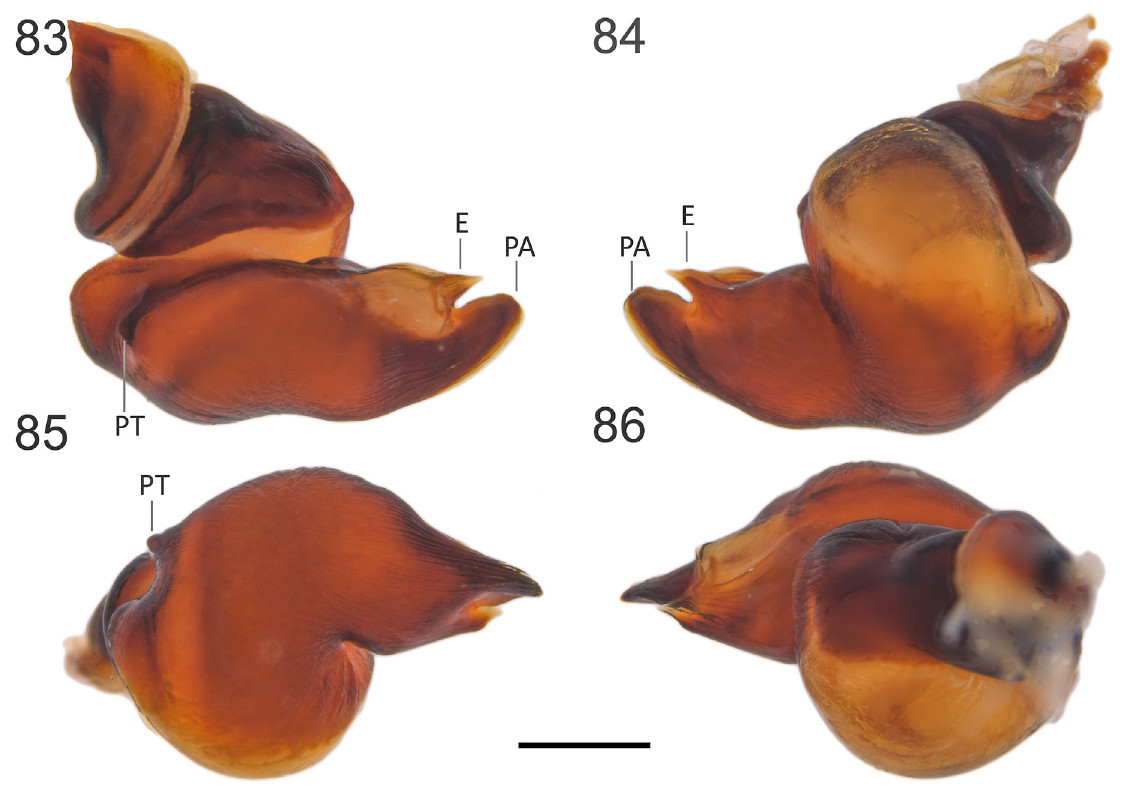
Figs 83–86 . Schismatothele weinmanni Guadanucci, Perafán & Valencia-Cuéllar, 2019, holotype, ♂ (ICN-Ar 8360), palpal bulb, prolateral (83), retrolateral (84), ventral (85), and dorsal (86) views. Abbreviations: E = embolus; PA = paraembolic apophysis; PT = prolateral tegular apophysis. Scale bar = 0.5